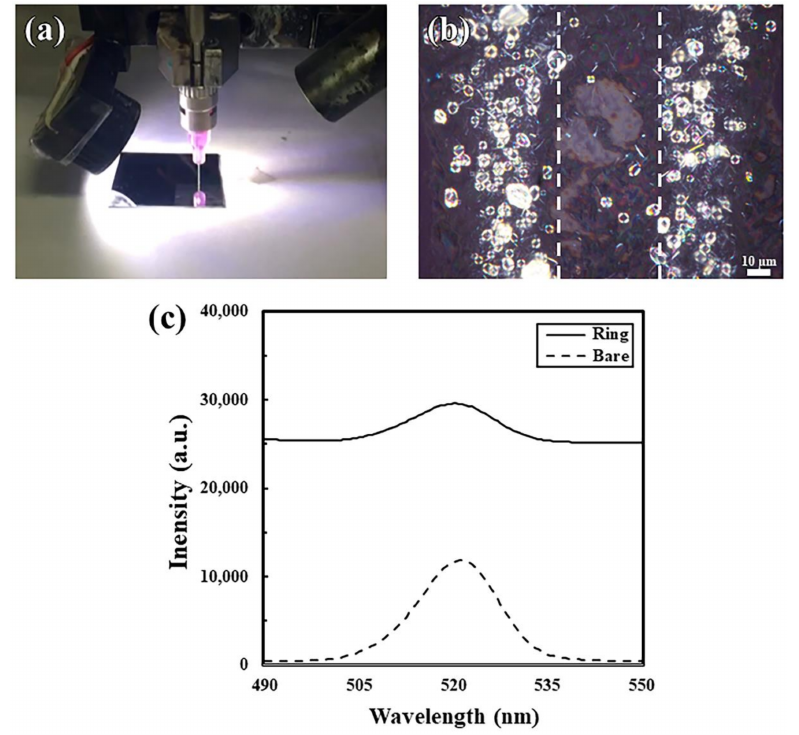
Figure 5. ( a ) Patterning with the micro-ring solution using electrohydrodynamic (EHD) jet printing, ( b ) a microscopic image of the micro-ring distribution, and ( c ) diagram of the Raman spectra for the Ag nanowire micro-ring structure and bare